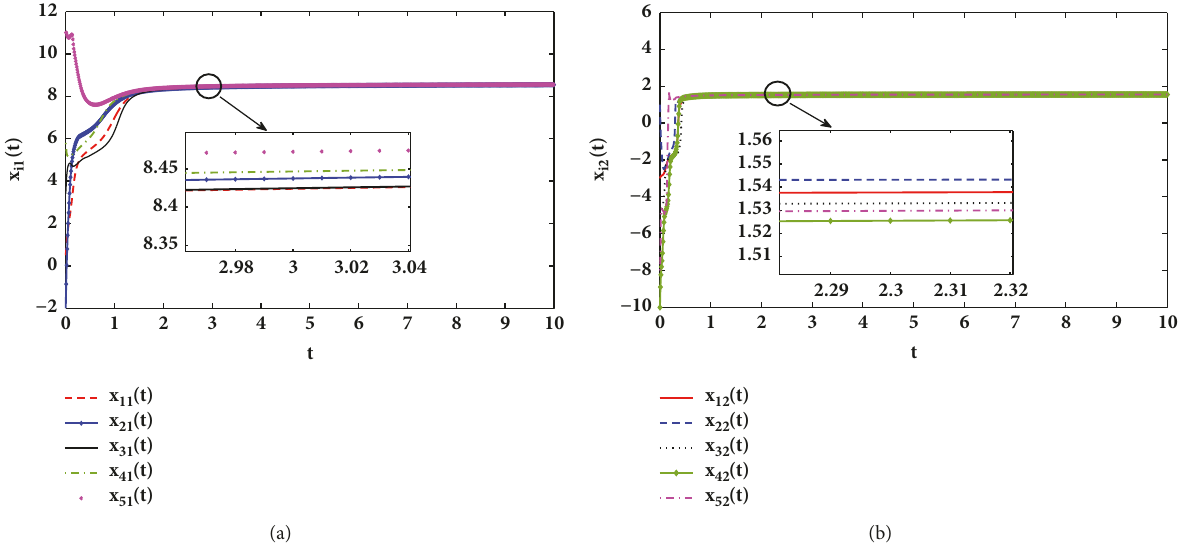
Figure 5: The states of the 𝑖 th agent (𝑖 = 1,2, 3,4,5) : (a) the state 𝑥 𝑖1 along 𝑥 -axis; (b) the states 𝑥 𝑖2 along 𝑦 -axis.